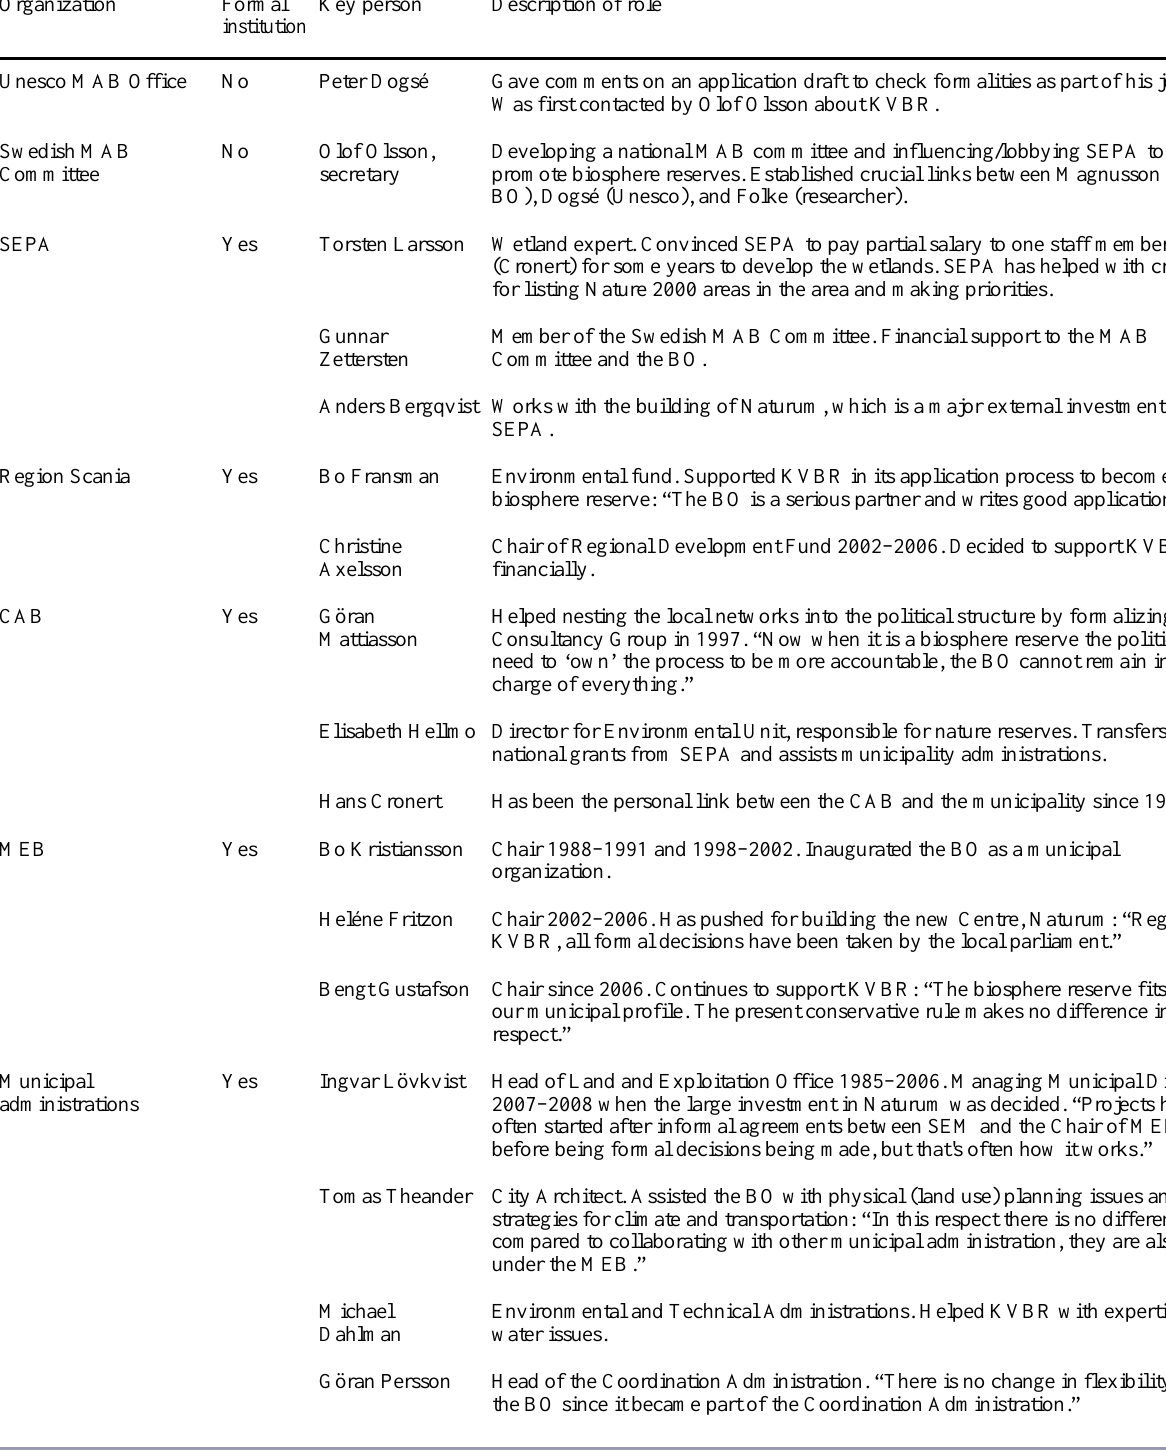
Table 1. Interviews with key persons of the governance network around KVBR